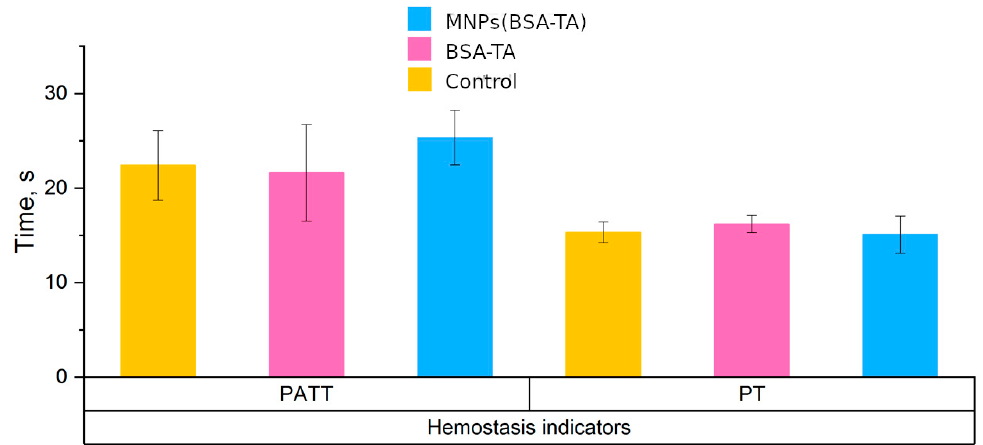
Figure 7. Effect of microcarriers on hemostasis: partially activated thromboplastin time (PATT) and prothrombin time (PT) in human blood plasma. Dose of carriers is 1 × 10 9 /mL. No effect of carriers on PATT and PT is present.